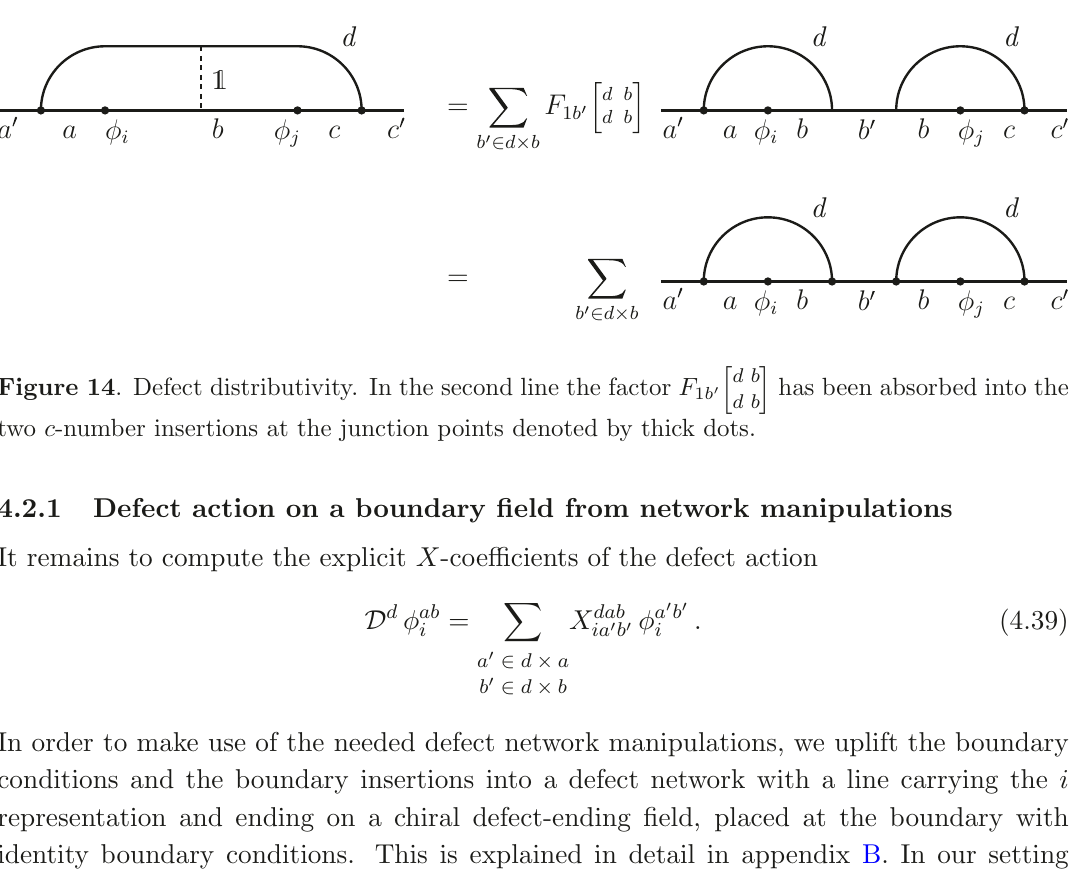
Figure 13 . The geometric description of a defect action on a boundary field. Notice the √ F factors at the junctions.